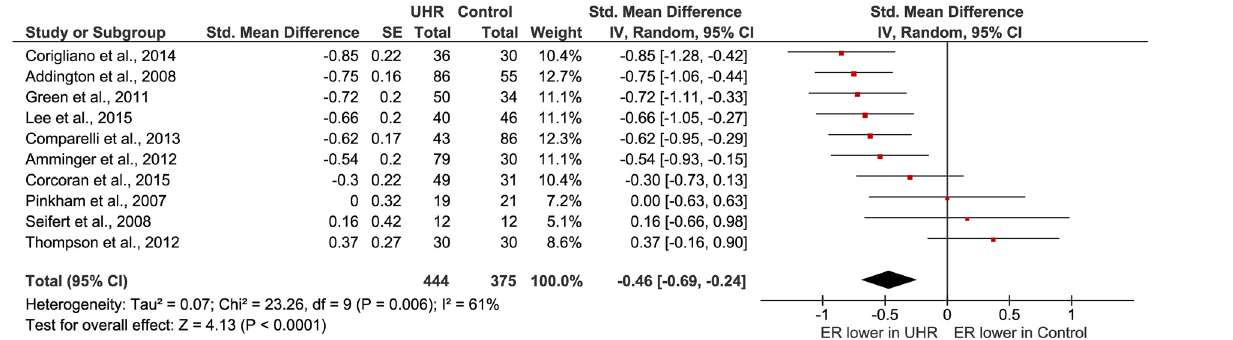
Fig 3. Forest plot of affect recognition in UHR versus healthy controls.